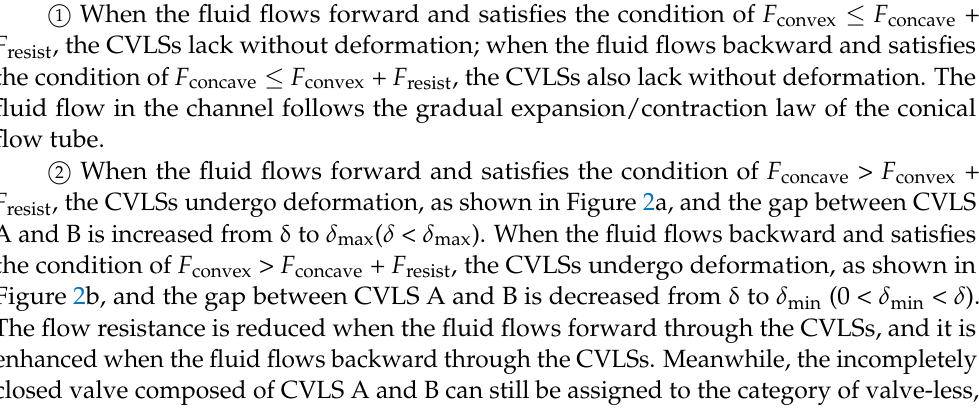
Figure 2. Valve-motion principle of CVLS: ( a ) Forward flow; ( b ) Reverse flow. ① When the fluid flows forward and satisfies the condition of F convex ≤ F concave + F resist , the CVLSs lack without deformation; when the fluid flows backward and satisfies the condition of F concave ≤ F convex + F resist , the CVLSs also lack without deformation. The fluid flow